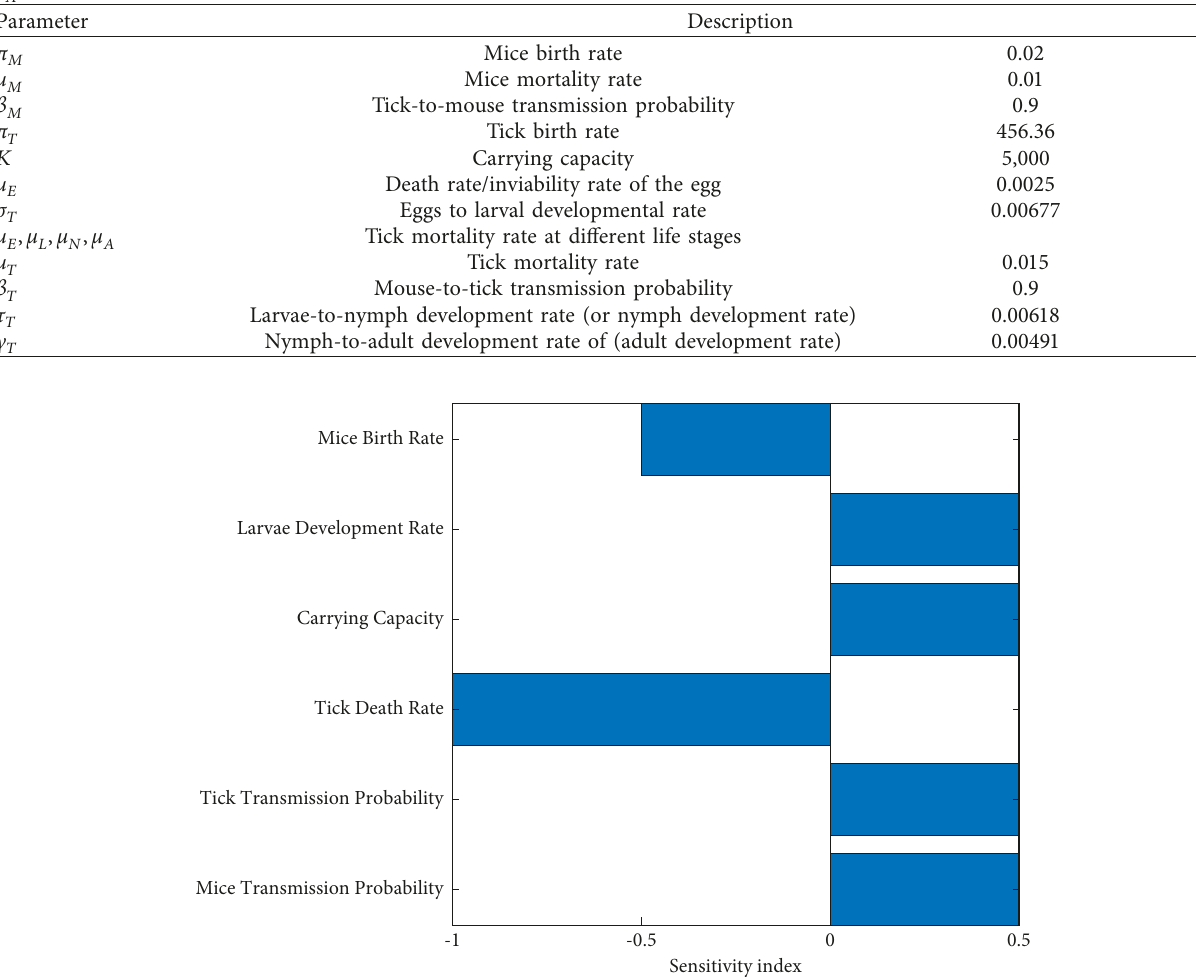
Figure 2: Sensitivity analysis results for the Lyme disease model. The larval development rate, the carrying capacity, and the disease transmission probability for both mice and ticks are all positive influences on R influences on R . Prescribed fire directly increases the tick death rate, making it an effective control strategy. 0